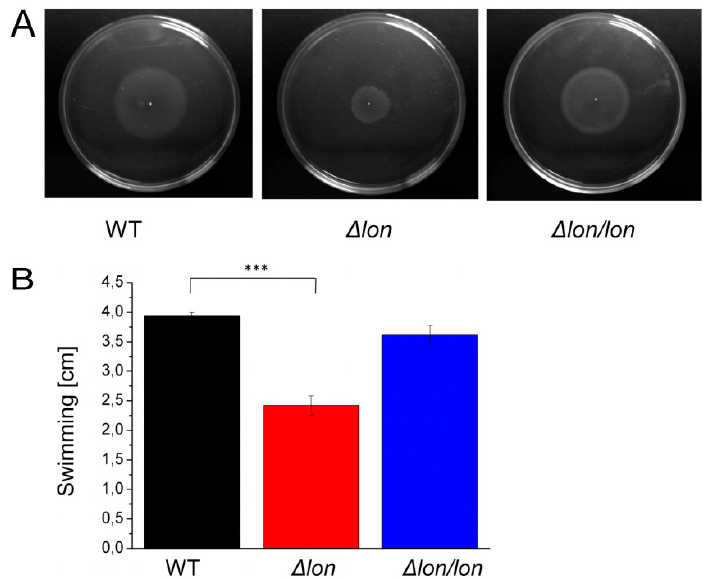
Figure 7. Swarming and swimming motility of D. solani ∆ lon . ( A ) Representative pictures of bacteria swarming on 0.8% TSA after 12 h incubation at 30 ◦ C. The experiments were performed at least five times. ( B ) Swimming was examined in a 0.3% MMA medium for 24 h at 30 ◦ C. The diameter of the bacteria spreading area was measured. Presented data represent values for 5 biological replicates. *** p < 0.001 level ( t -test).